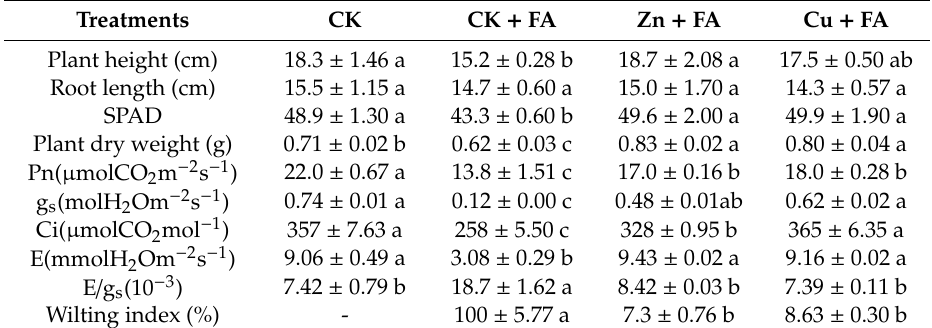
Table 1. Growth and photosynthesis parameters of cucumber plants regulated by Zn and Cu under fusaric acid